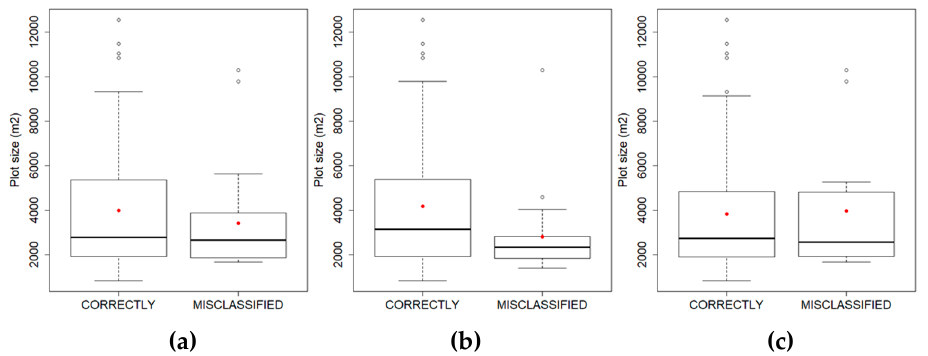
Figure 8. Boxplots of the plots correctly classified and misclassified by Model 1 ( a ), Model 2 ( b ) and Model 3 ( c ).